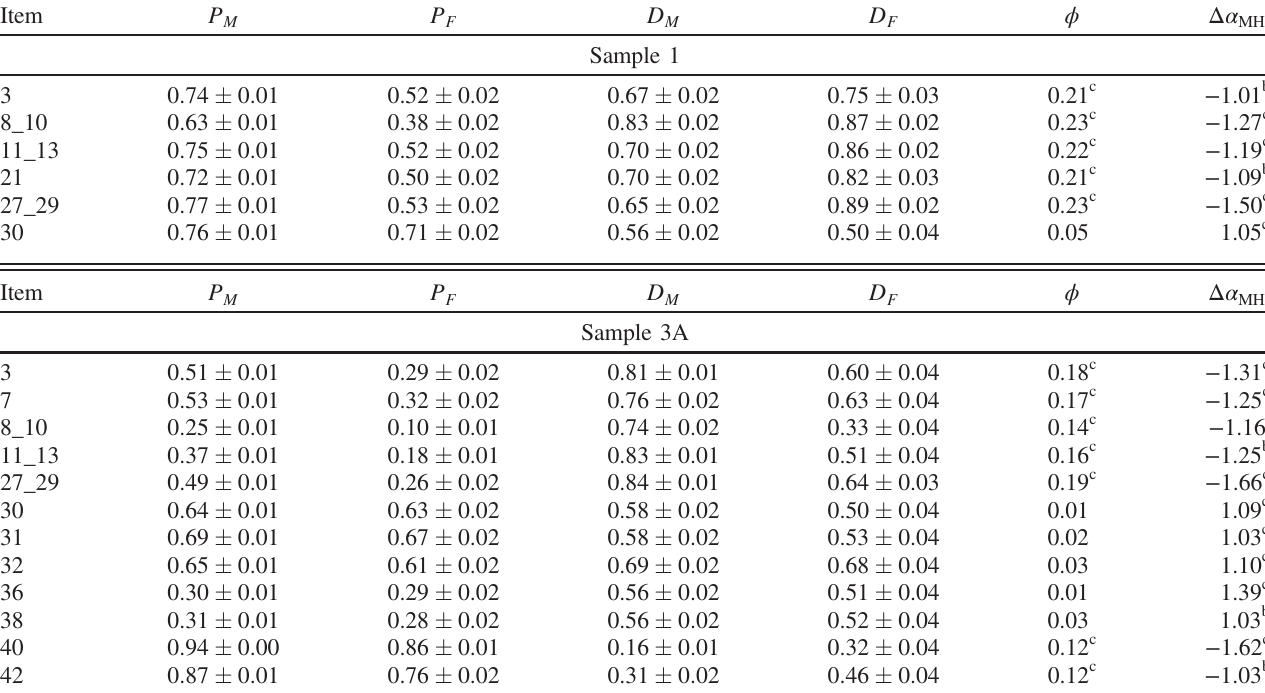
TABLE IV. CTT difficulty and discrimination and DIF Δ α for the FMCE post-test items with small-to-moderate or large DIF. The MH significance levels have been Bonferroni corrected: “ a ” denotes p < 0 . 0016 , “ b ” denotes p < 0 . 0003 , and “ c ” denotes p < 0 . 00003